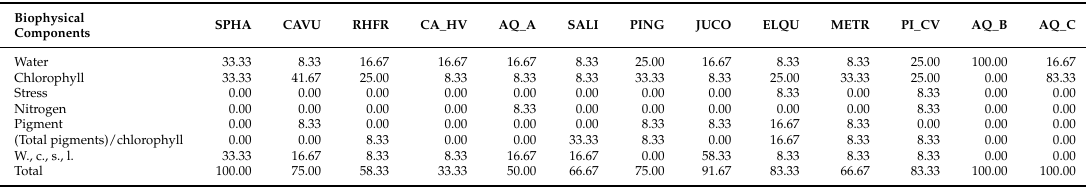
Table 13. Single main discriminating biophysical components for each vegetation type and their occurrences